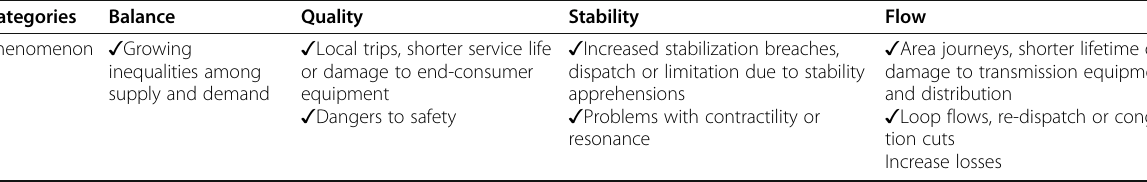
Table 2 The categorization of challenges according to the root cause analysis Categories